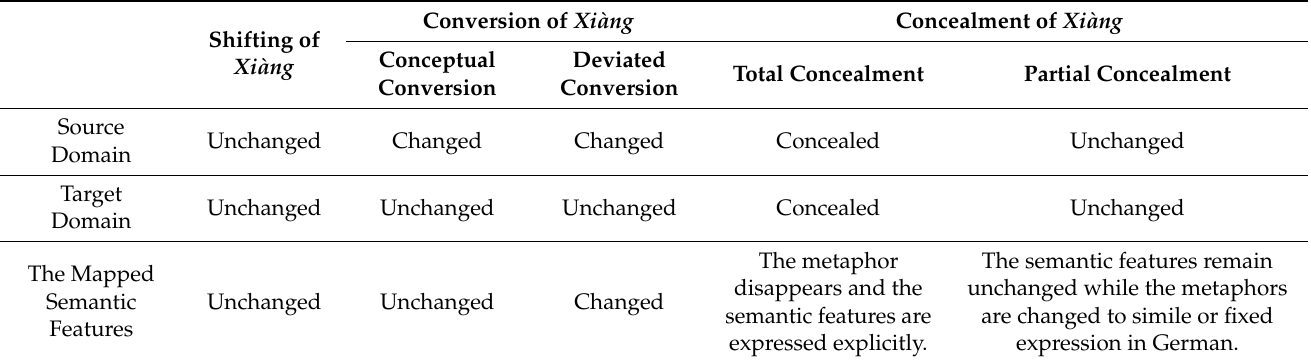
Table 9. Features of the Transfer Modes of Xi à ng in German